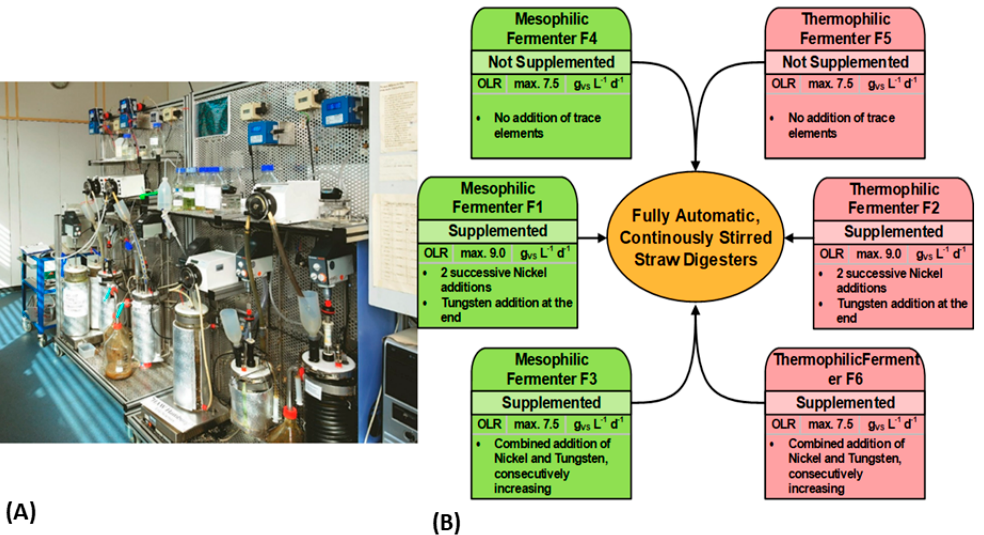
Figure 1. ( A ) A view of the continuously operated and fully automated 6-L laboratory anaerobic fermenters, developed and built at the university campus in Hamburg-Bergedorf. ( B ) Graphical summary of the experimental design for wheat straw digestion with ‘synthetic manure’, over a period of nearly 3 years. Investigation of temperature influence, OLR, and trace element requirements, during mesophilic (41 °C, green) and thermophilic (58 °C, red) fermentation. The following values of OLR and HRT were adjusted: low OLR 4.5 (HRT 18 days), medium OLR 7.5 (HRT 10 days), and high OLR 9.0 gVS/L/d (HRT 8 days). Two trace element supplementation strategies were implemented: 1 . Successive increment of nickel (Ni) in 4 periods with different OLRs, then final addition of tungsten (W) in period 5 in fermenter F1 and F2. 2 . Combined addition of Ni and W in fermenter F3 and F6 in three periods with the same OLR: from the beginning with a low sum ∑ (Ni + W), followed by an increased sum ∑ (Ni + W). F4 and F5 were reference fermenters, without trace element supplementation.